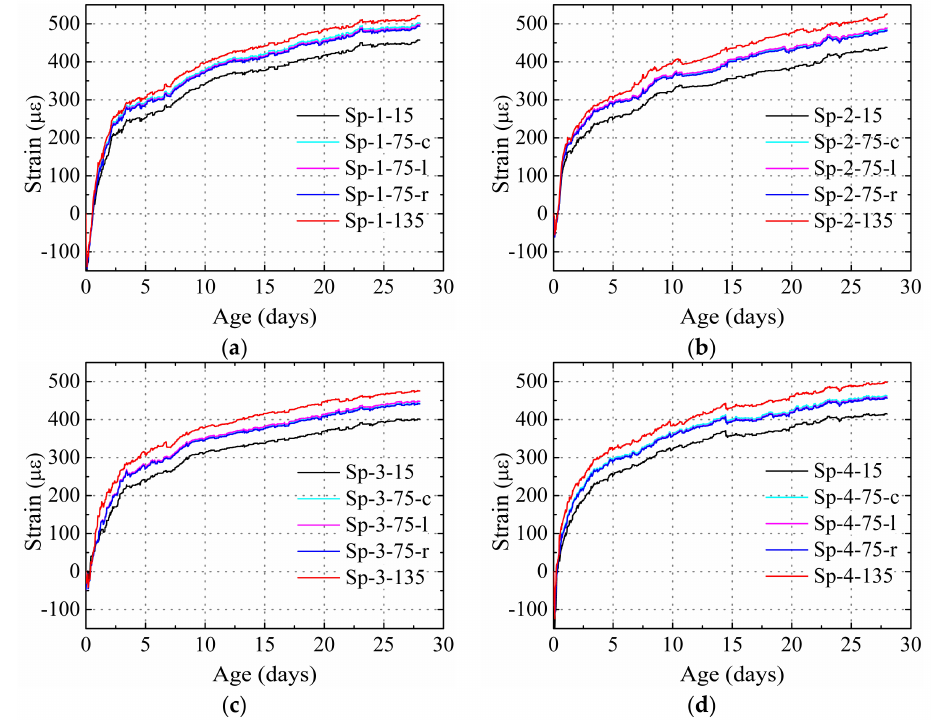
Figure 6. Measured strain for specimens restrained only by steel plate: ( a ) Sp-1, ( b ) Sp-2, ( c ) Sp-3, and ( d )